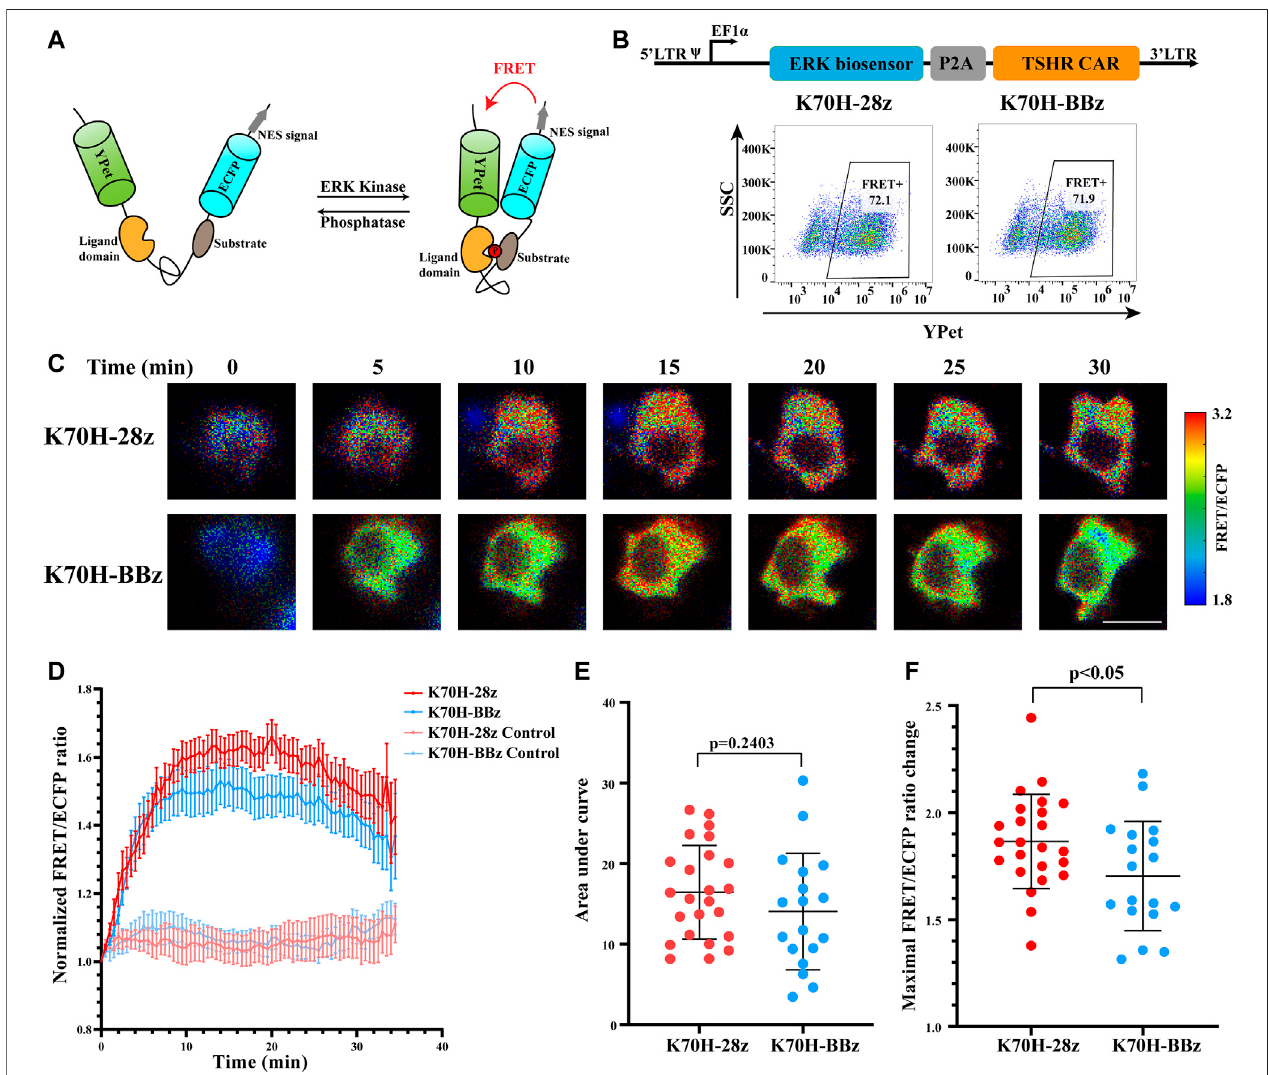
FIGURE 4 | Signaling dynamics of ERK in CAR-T cells upon antigen stimulation. (A) Design of ERK FRET biosensor. (B) Biosensor (CAR) expression of Jurkat T cells transduced with ERK biosensor and TSHR CARs. (C) ERK signal changes of CAR-Jurkat T cells over time after contacting with K562-TSHR cells. The activity of ERK was visualized by FRET/ECFP ratio. Scale bar: 10 μ m. (D) Time courses of FRET/ECFP ratio of ERK biosensor in K70H-28z or K70H-BBz CAR-Jurkat T cells stimulated by K562-TSHR ( n = 24 and 18 respectively) or K562 (Control, n = 14 and 14 respectively). Error bars: mean ± SEM. Accumulated signal intensity (area under curve) (E) and maximal FRET/ECFP ratio changes (F) of ERK biosensor in CAR-Jurkat T cells. Error bars: mean ± SD.